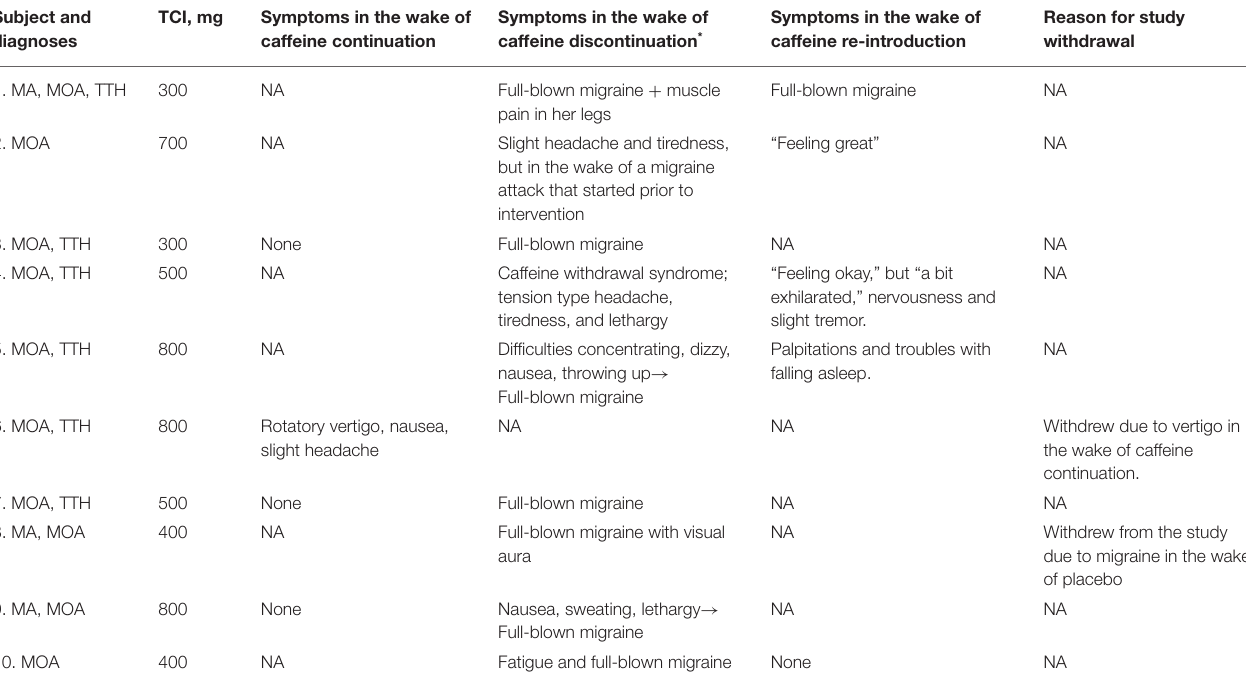
TABLE 2 | Withdrawal symptoms in each study